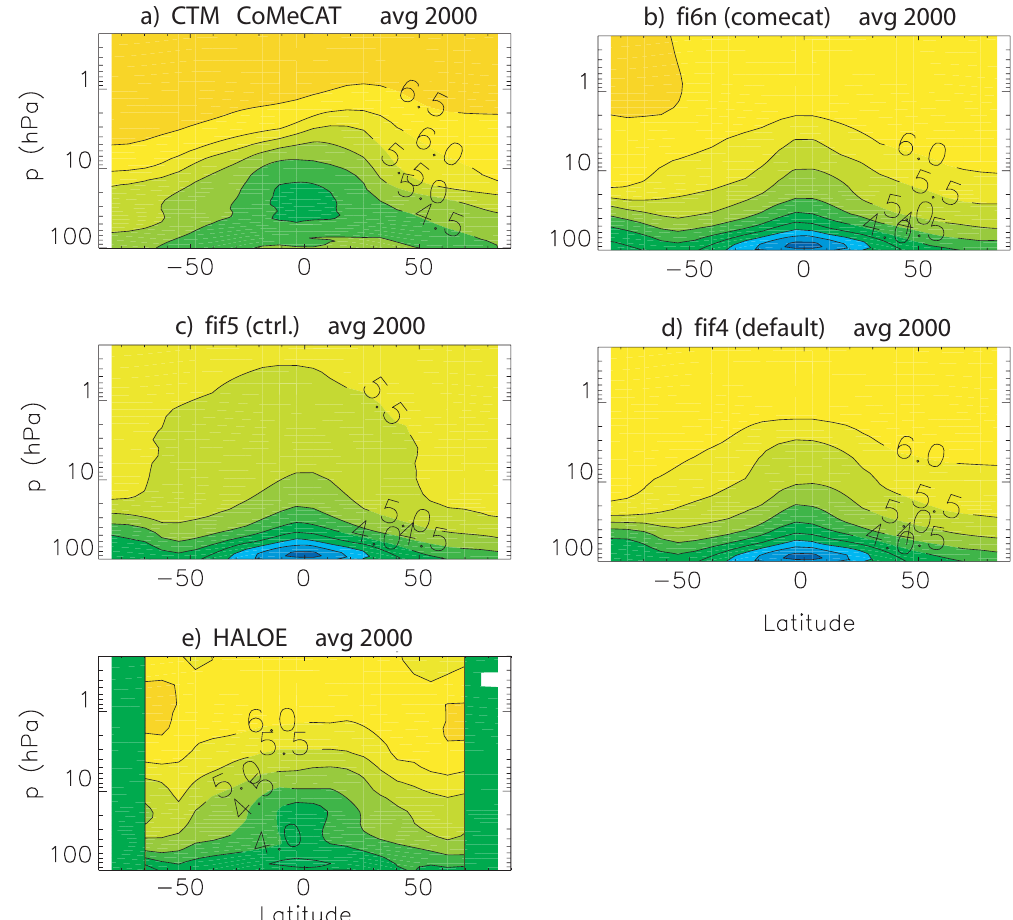
Fig. 8. H 2 O (ppmv) cross sections averaged over year 2000 obtained from (a) CoMeCAT in the SLIMCAT run13, (b) CoMeCAT in ECMWF run fi6n, (c) ECMWF control run fif5, (d) ECMWF default scheme in run fif4 and (e) HALOE instrument. Colour scale goes from larger concentrations (orange) to smaller concentrations (dark blue). Contour interval is 0.5ppmv. HALOE observations are available for the latitudinal range 80 ◦ S–80 ◦